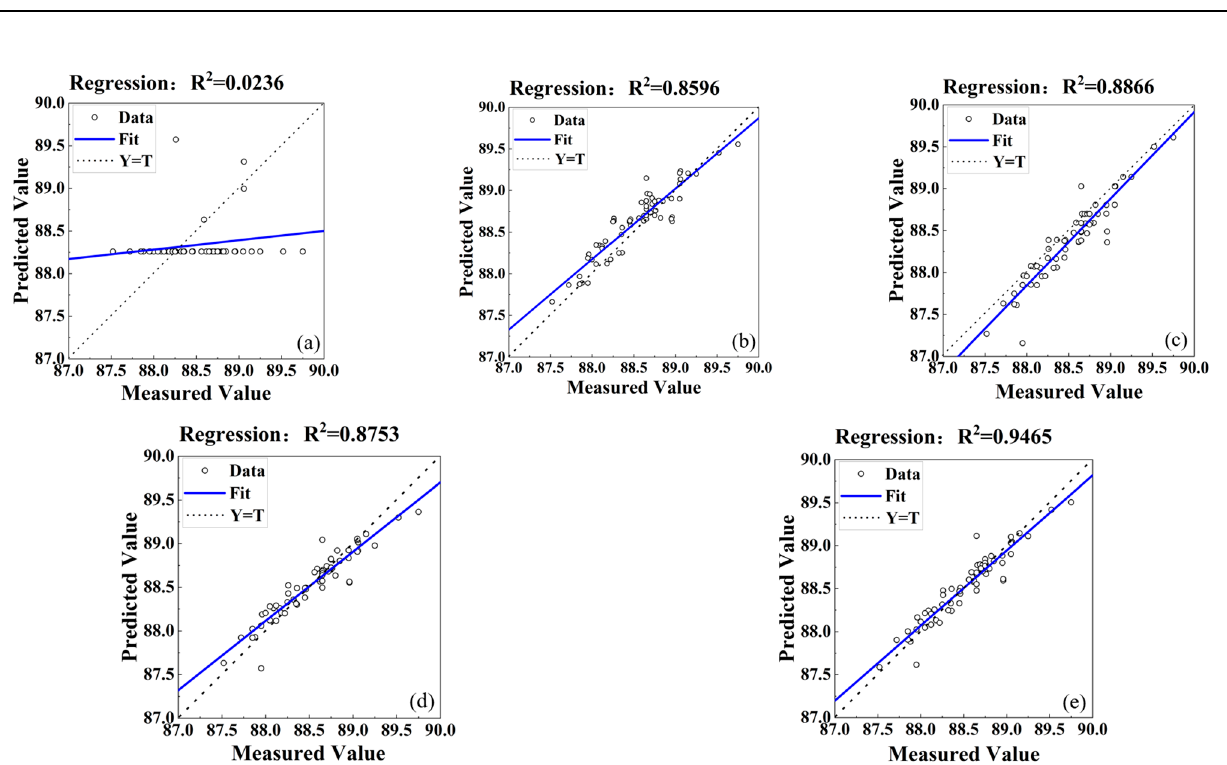
Figure 7. Regression between the predicted and measured values with different algorithms: ( a )